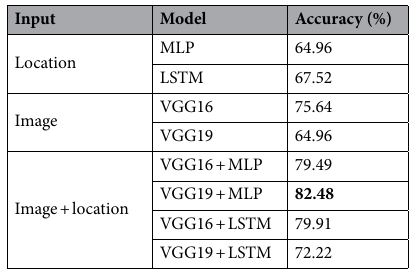
Table 5. Six-class classification (BG vs. N vs. D vs. P vs. S vs. V) on AZH dataset. The bold represents the highest results/accuracy achieved for each experiment.